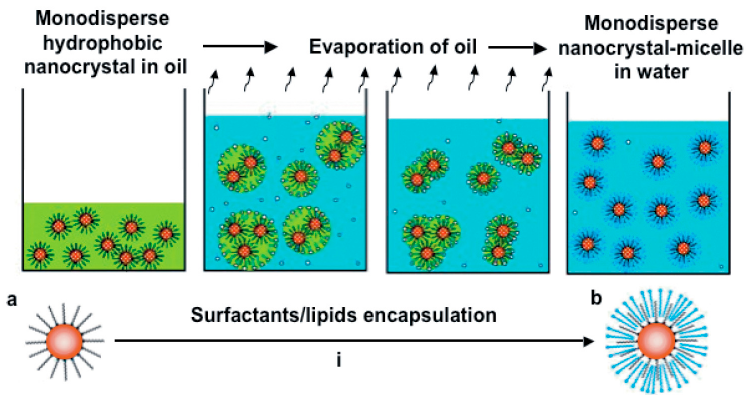
Figure 8. Representation of the formation of water-dispersible IO NPs through surfactant encapsulation [121]. Reprinted (adapted) with permission from [121].